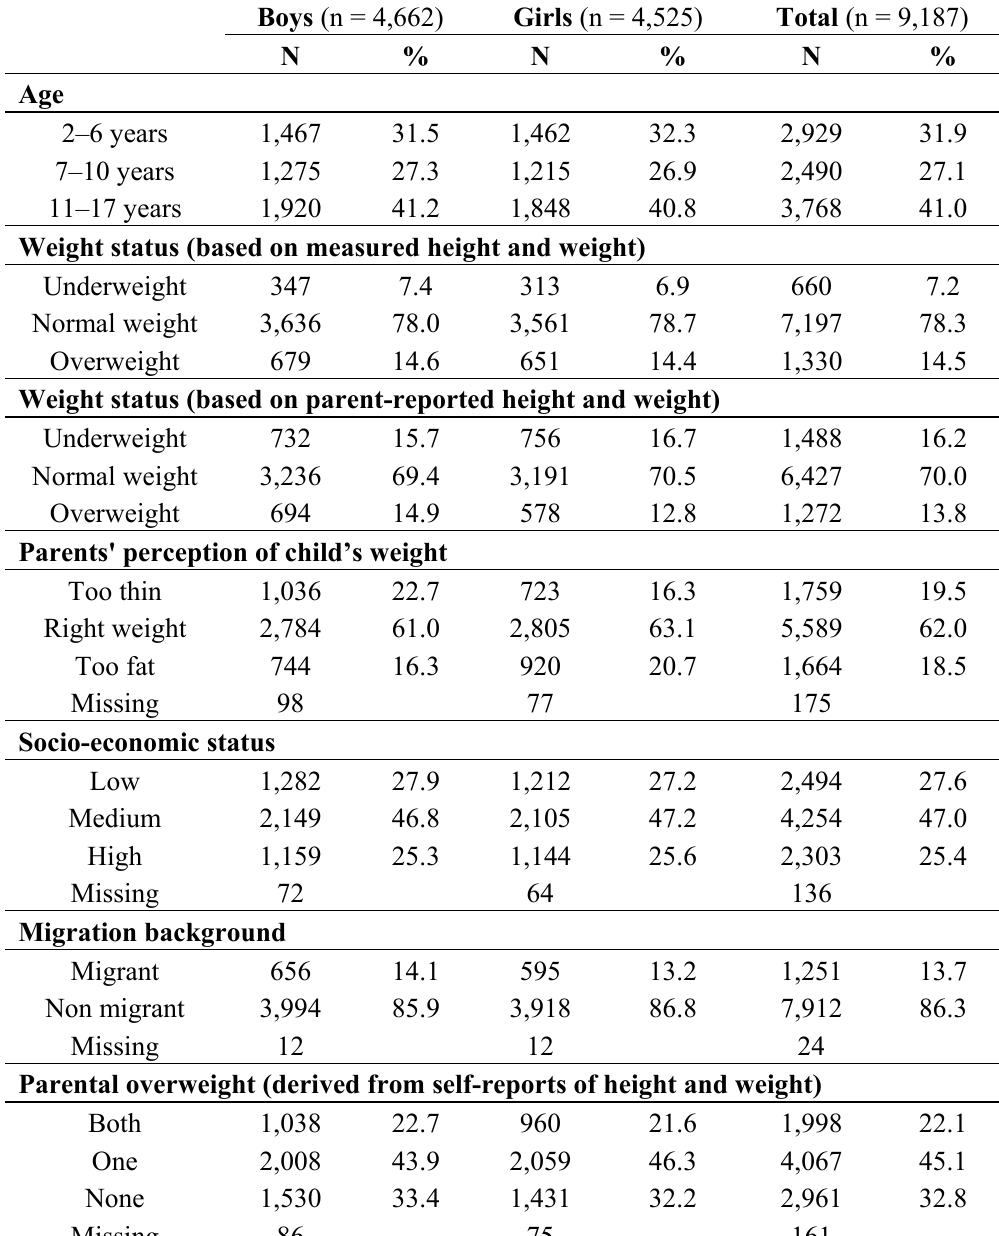
Table 1. Description of the study